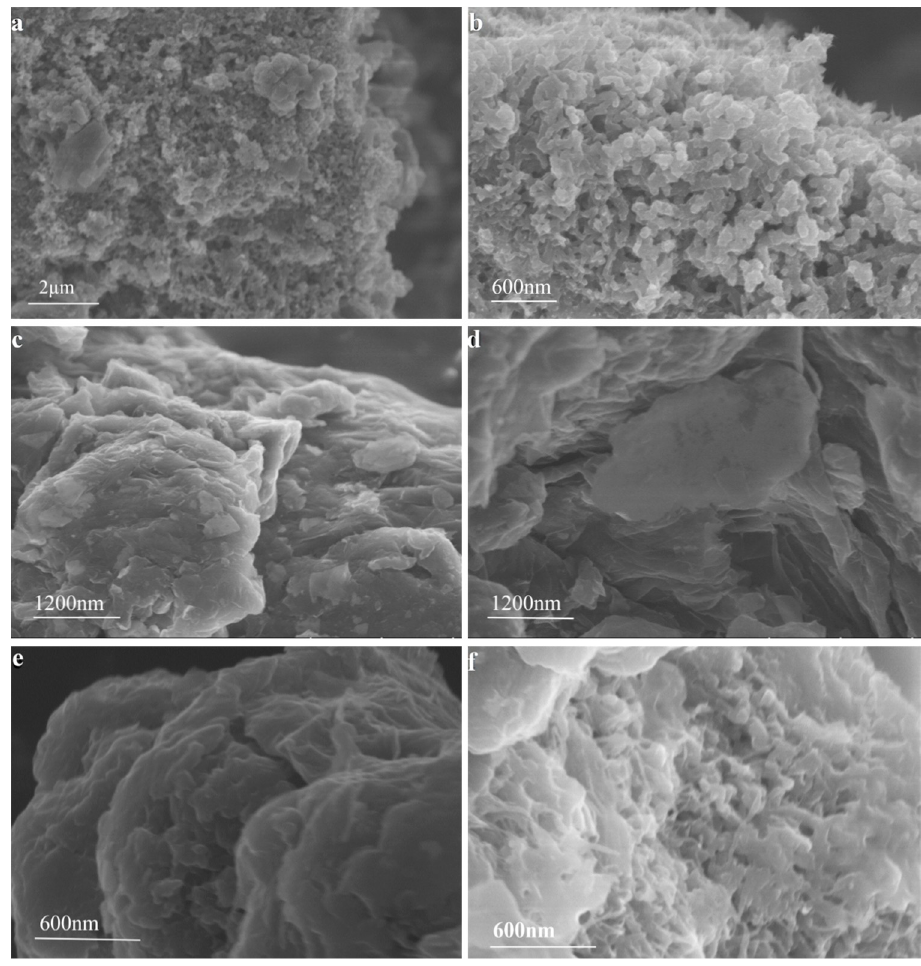
Figure 7. SEM images of ( a , b ) PANI; ( c ) GO; ( d ) M-GO; ( e ) PANI/GO; and ( f ) PANI/M-GO